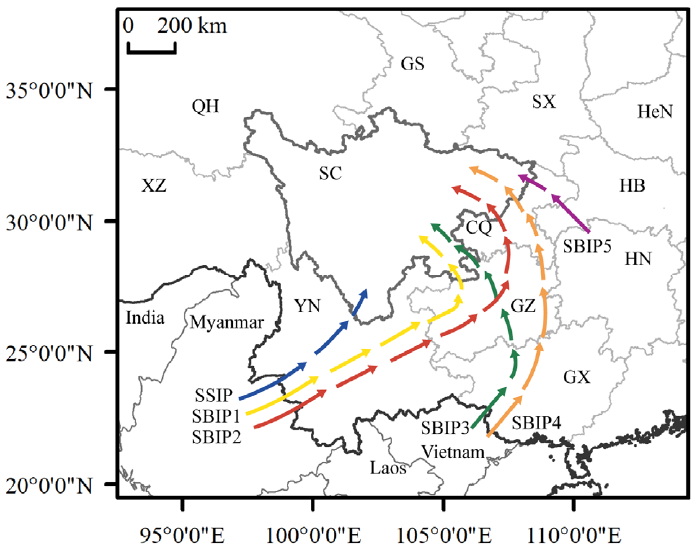
Figure 5. The FAW migratory pathways to Sichuan. There are 6 potential migratory pathways to Sichuan, 1 southwest Sichuan migratory pathway and 5 Sichuan Basin migratory pathways. SSIP: Southwest Sichuan migratory (Blue arrow). SBIP1: Sichuan Basin migratory pathway 1 (yellow arrow). SBIP2: Sichuan Basin migratory pathway 2 (red arrow). SBIP3: Sichuan Basin migratory pathway 3 (green arrow). SBIP4: Sichuan Basin migratory pathway 4 (orange arrow). SBIP5: Sichuan Basin migratory pathway 5 (purple arrow). The two-letter codes refer to the different provinces of China (SC: Sichuan Province, YN: Yunnan Province, GX: Guangxi Zhuang Autonomous Region,